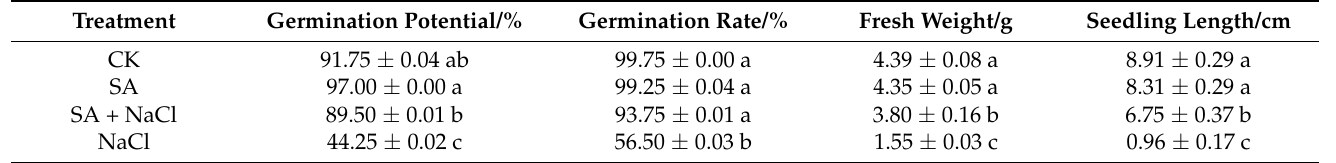
Table 1. Effect of different treatments on germination of melon seeds. Treatment Germination